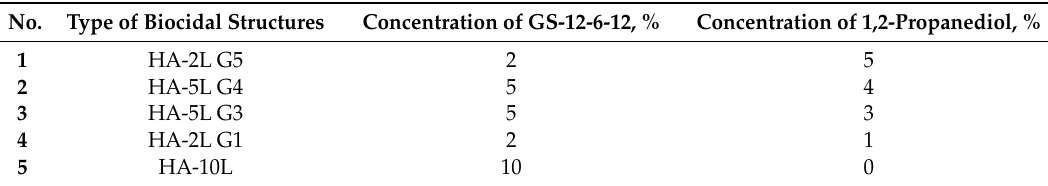
Table 2. The characteristics of the structures used to prepare